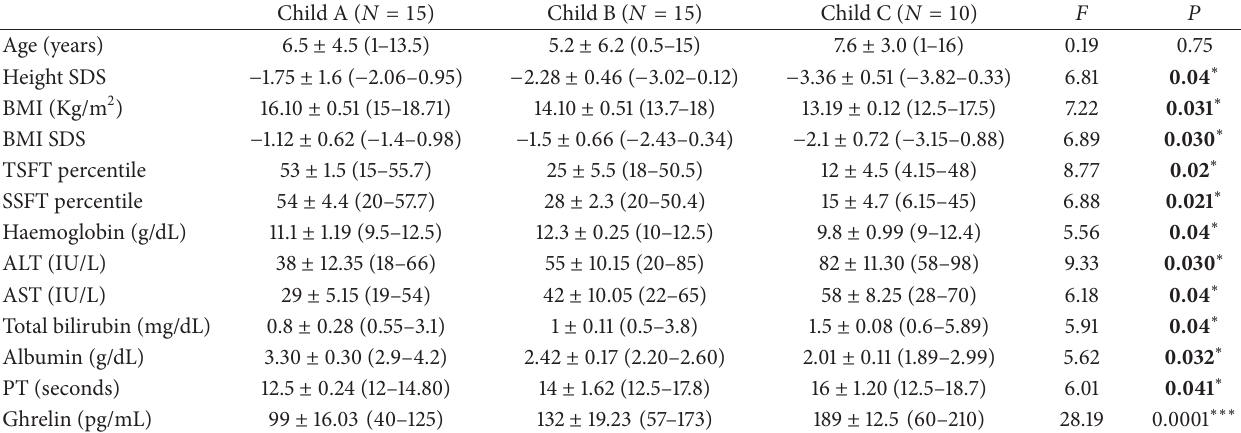
Table 2: Clinical and laboratory data according to severity of liver disease among studied cases ( 𝑛 = 40